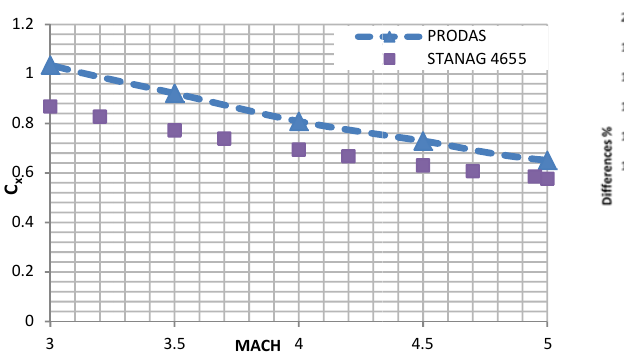
Figure project 3.2. CFD vs The results o results of PR 3, where the coefficients